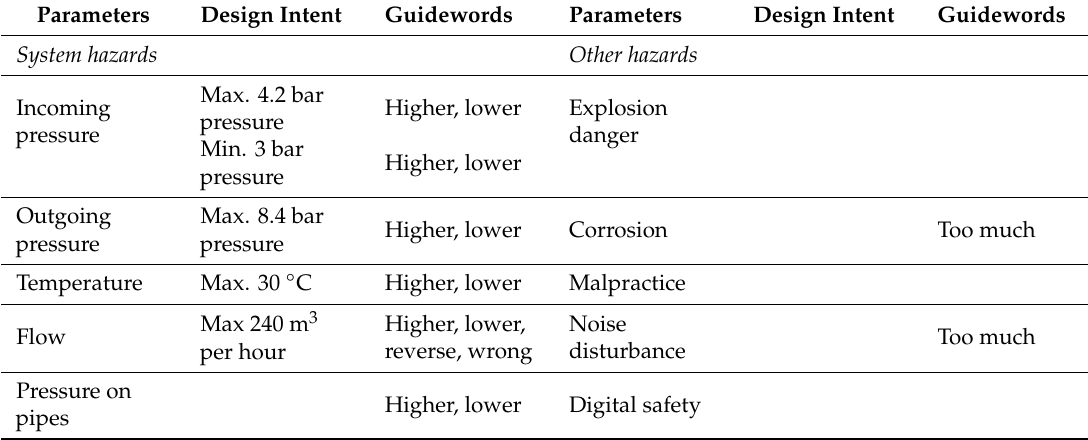
Table 3. Considered parameters in the hazard and operability study (HAZOP), along with design intent and